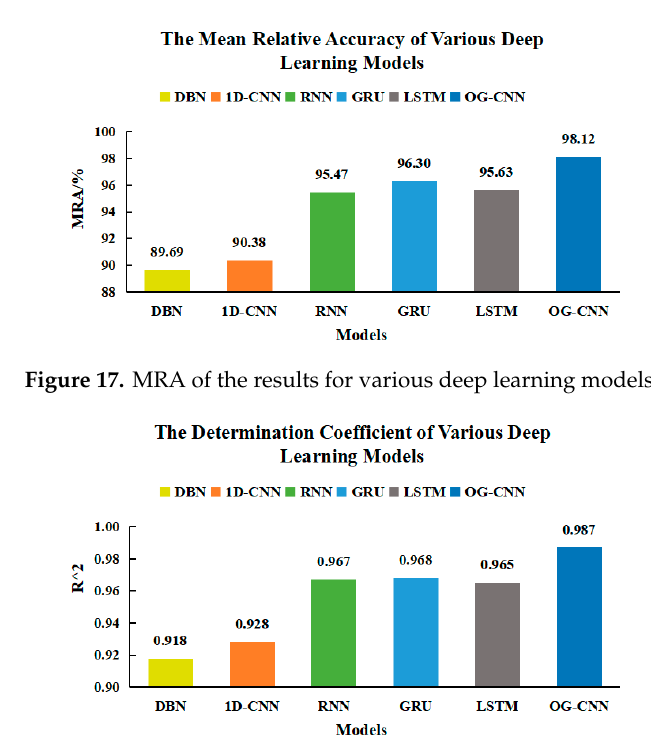
Figure 18. R 2 of the results for various deep learning models.